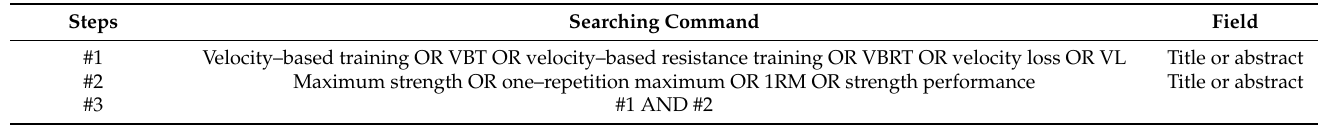
Table 1. Searching strategy for study inclusion. Searching